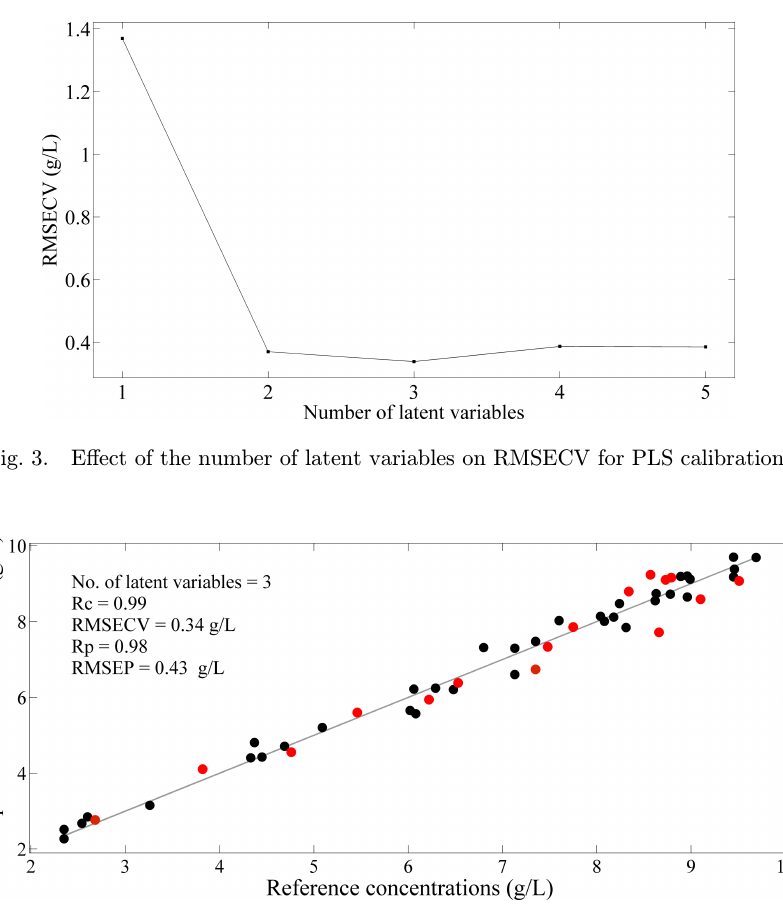
Fig. 4. Reference concentrations measured versus NIR predicted by PLS in the calibration and prediction set, respectively (black circles represent calibration set; red circles represent the prediction set).